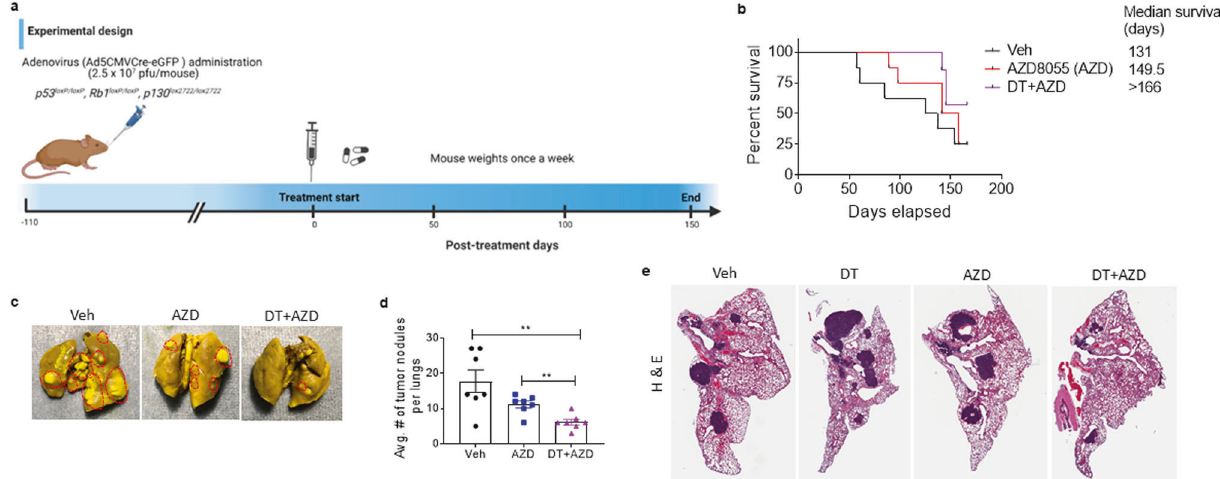
Fig. 6 The combination of DT2216 and AZD8055 has stronger antitumor responses as compared to individual agents in a GEM model of SCLC. a Experimental design of Rb1/p53/p130 GEM model. Mice were administered with 2.5 × 10 7 pfu/mouse of Ad5CMVCre-eGFP through nasal inhalation. Treatment was started 110 days post-infection and continued until day 150. Speci fi cally, the mice were treated with vehicle (veh), AZD8055 (AZD, 16 mg/kg/5x week, p.o.) and AZD (16 mg/kg/5x week, p.o.) + DT2216 (DT, 15 mg/kg/q4d, i.p.) ( n = 8, 8 and 7 mice in veh, AZD and combo groups, respectively). The fi gure was adapted from BioRender. b Kaplan – Meier survival analysis of mice as treated in a . The median survival time is shown on the right. At the end of the experiment (day 166), 2, 2, and 4 mice were alive in veh, AZD and DT + AZD groups, respectively. c Bouin ’ s-stained represented images of excised lungs from veh, AZD, and DT + AZD groups. The tumor nodules in the lungs are circled. As shown, the tumor nodules were considerably smaller in the lungs of combination-treated mice as compared to veh or AZD-treated mice. d The Number of tumor nodules was counted on both dorsal and ventral sides of the lungs and the average number of tumor nodules per mouse lungs in each group is shown (mean ± SEM, n = 7). Statistical signi fi cance was determined by a two-sided unpaired Student ’ s t test. ** p < 0.01. e Hematoxylin and eosin (H&E) staining of representative lung sections in veh, DT, AZD, and DT + AZD groups from a separate experiment in which the mice were treated with veh, DT (15 mg/kg/q4d, i.p.), AZD (16 mg/kg/5x week, p.o.), and a combination of DT and AZD. The mice were euthanized 24 h after the last